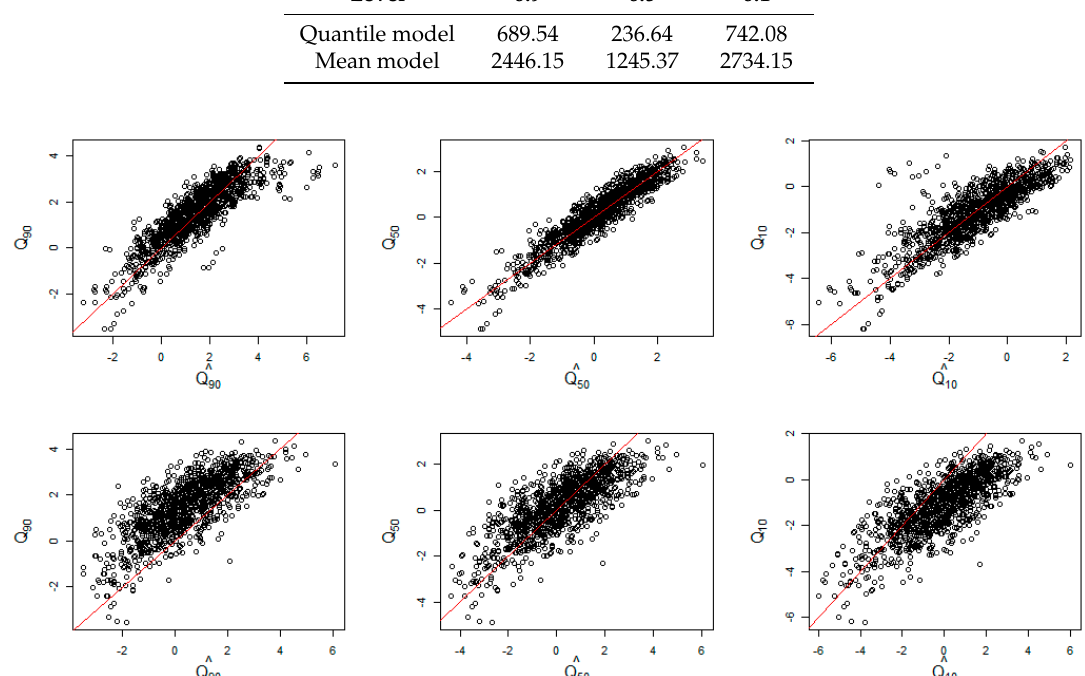
Figure 4. Scatterplots of simulated and estimated from quantile ( upper ) versus mean ( lower ) regression models at 10th (left), 50th (middle), and 90th (right) quantiles on the log scale. The red line represents the equality of the predicted and true quantiles.